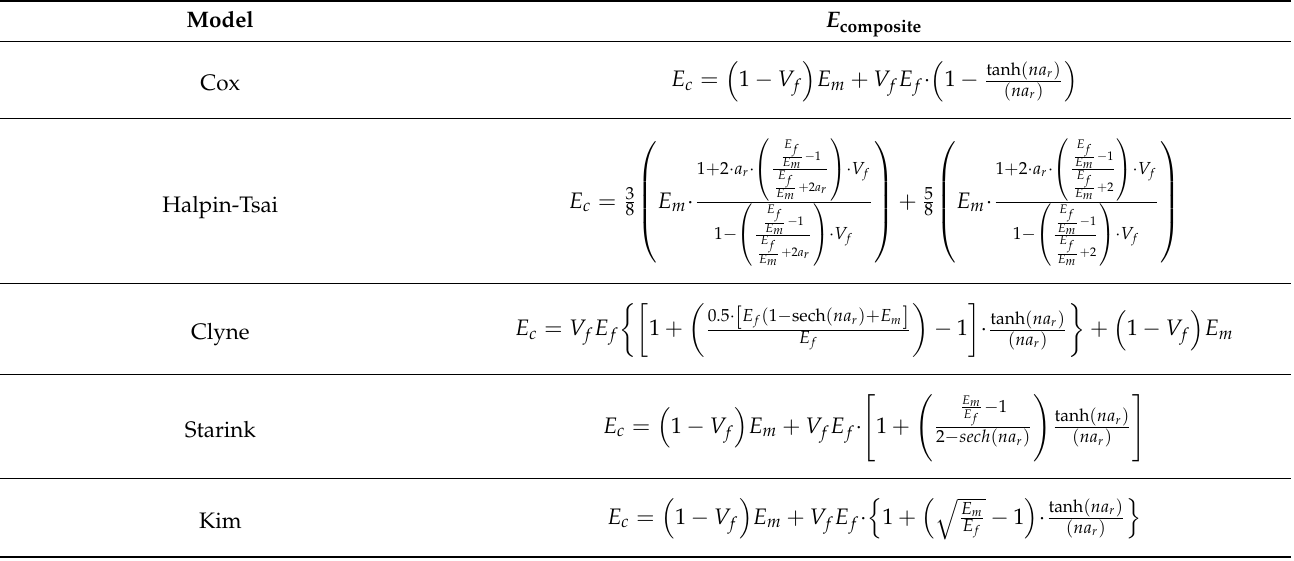
Table 2. List of the analytical expressions used in this work for the prediction of the biocomposites